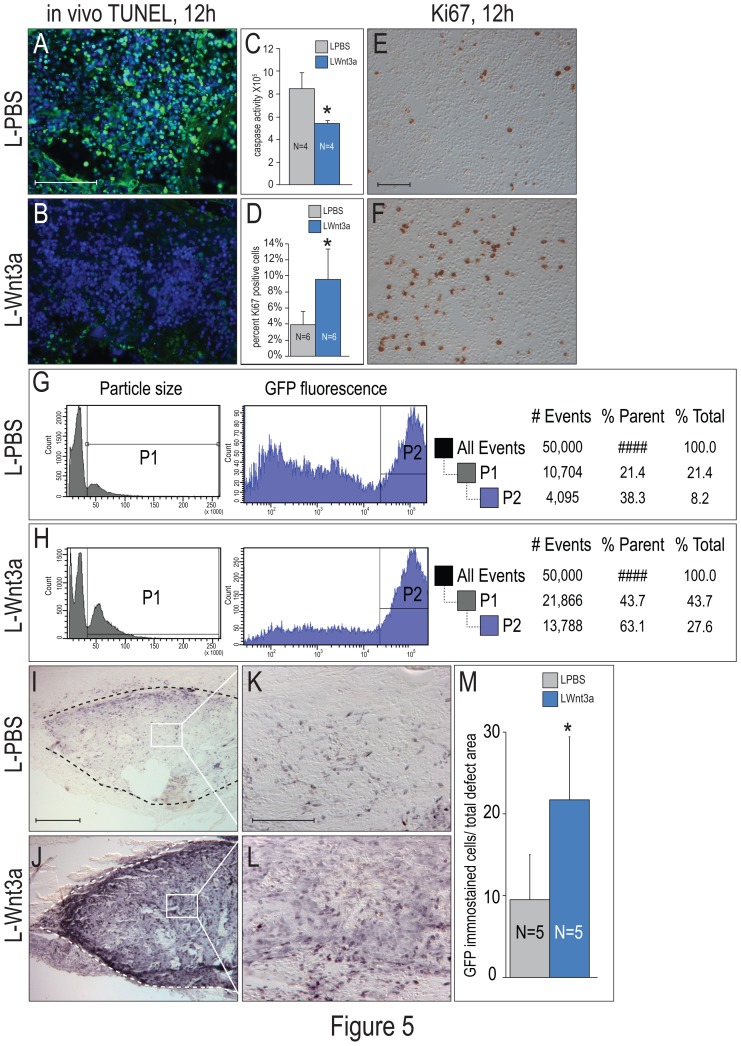
L-Wnt3a stimulates the survival, proliferation, and engraftment of bone marrow cells.(A) Aged BMT were treated with L-PBS or (B) L-Wnt3a with an effective concentration = 150 ng/ml, then transplanted into a skeletal defect and after 12 h, analyzed for DNA fragmentation associated with cell apoptosis using TUNEL. (C) Quantification of caspase activity in aged BM treated with L-PBS (grey bar; N = 4) or L-Wnt3a (blue bar; N = 4). (D) Quantification of Ki67 immunostaining for aged BM treated with (E) L-PBS or (F) L-Wnt3a, then transplanted into a skeletal defect and after 12 h analyzed for cell proliferation. (G) FACS analyses of L-PBS treated BMT, harvested from the defect site on post-transplant day 5. (H) FACS analyses of L-Wnt3a treated BMT, harvested from the defect site on post-transplant day 5. (I) GFP immunostaining identifies the L-PBS treated BMT on post-transplant day 7 (J) GFP immunostaining identifies the L-Wnt3a treated BMT on post-transplant day 7. (K) GFP immunostaining shown in higher magnification demonstrating L-PBS treated BMT on post-transplant day 7 (L) GFP immunostaining shown in higher magnification demonstrating L-Wnt3a treated BMT on post-transplant day 7 (M) Histomorphometric quantification of GFP immunopositive cells in the defect site on post-transplant day 7 (N = 5 for each condition). Abbreviations: GFP: green fluorescent protein; TUNEL: Terminal deoxynucleotidyl transferase dUTP nick end labeling; Scale bars: A,B: 50 µm E,F: 100 µm; I,J: 200 µm; K,L: 50 µm.